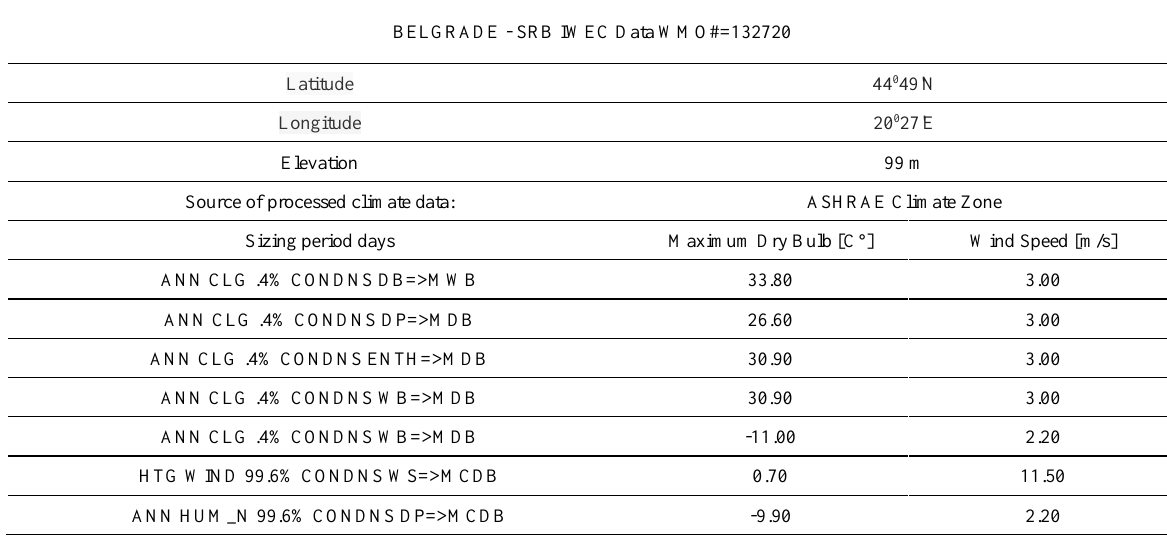
Table 1. Climatic Data Summary for Belgrade, sizing period